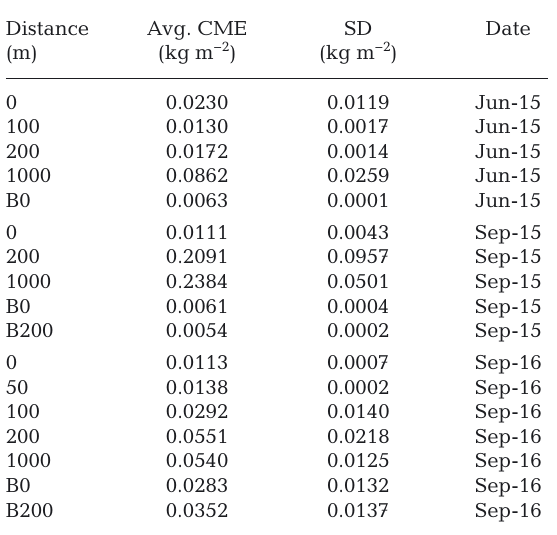
Fig. 5. Jordan Bay cumulative mass eroded (CME) from all samplings. The sample stations are in the direction of mean flow and represent distance from the site with the 0 m sta- tions representing the opposite sides of the cage site. See Fig. 1 for more detail on sampling layout. Error bars: 1 SD Table 1. Average CME values for Jordan Bay. Please see Fig. 1 for detail on sample